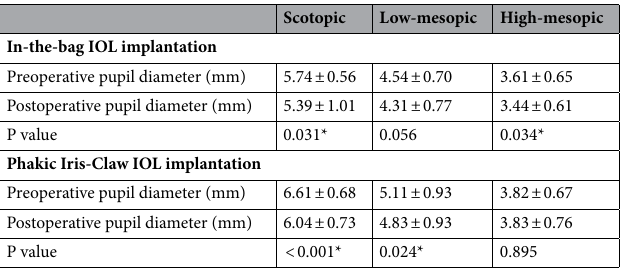
Table 2. Pre- and postoperative pupil dynamics in patients undergoing regular in-the-bag IOL implantation and phakic Iris-Claw IOL implantation. P-values origin from a two-level linear mixed model. *indicates statistical significance with p < 0.05.